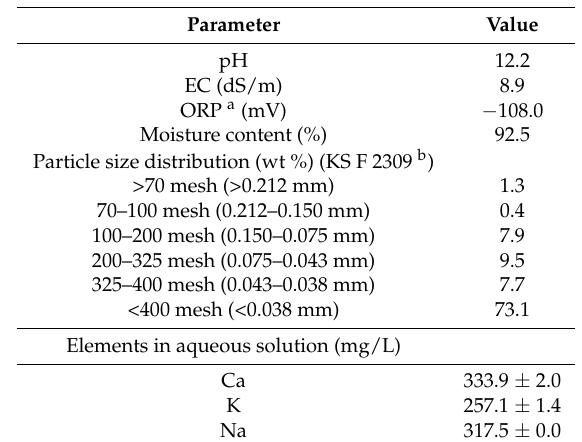
Table 1. Physicochemical properties of concrete sludge used in this study.